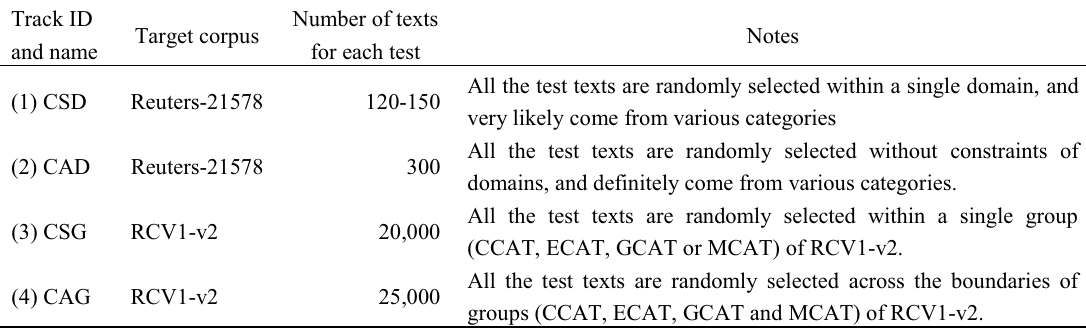
Table 1. List of experimental tracks